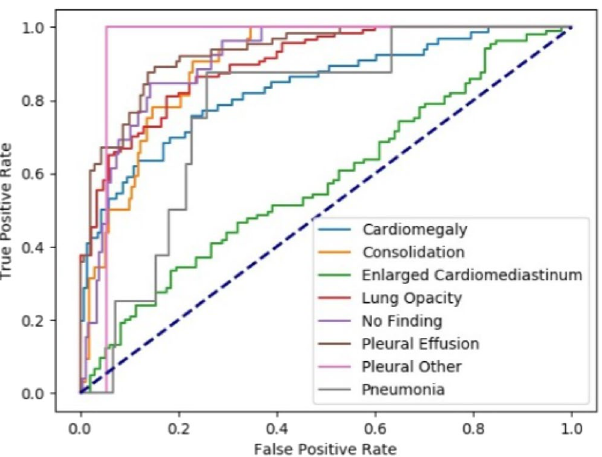
Figure 4. ROC curves of our model for different pathologies on CheXpert validation dataset.